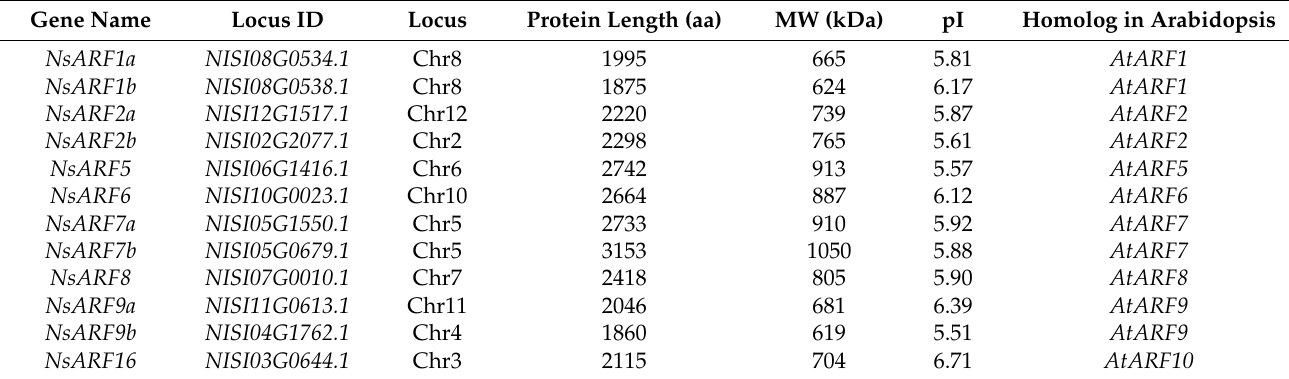
Table 1. Summary of N. sbirica ARF gene family members.